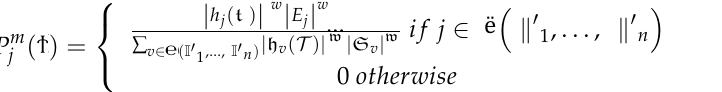
Figure 3. 4-BSMAB best activation visualizations of an image at various convolutional layers: ( a ) original image; ( b ) C1_1; ( c ) C2_1; ( d ) C2_2; ( e ) C3_1; ( f ) C3_2; ( g ) C4_2; ( h ) C7_1.